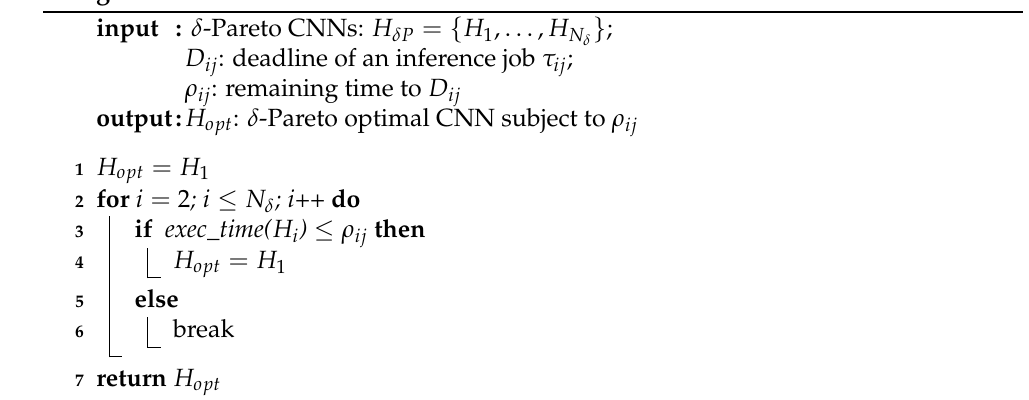
Algorithm 2: Run-Time Selection of a CNN